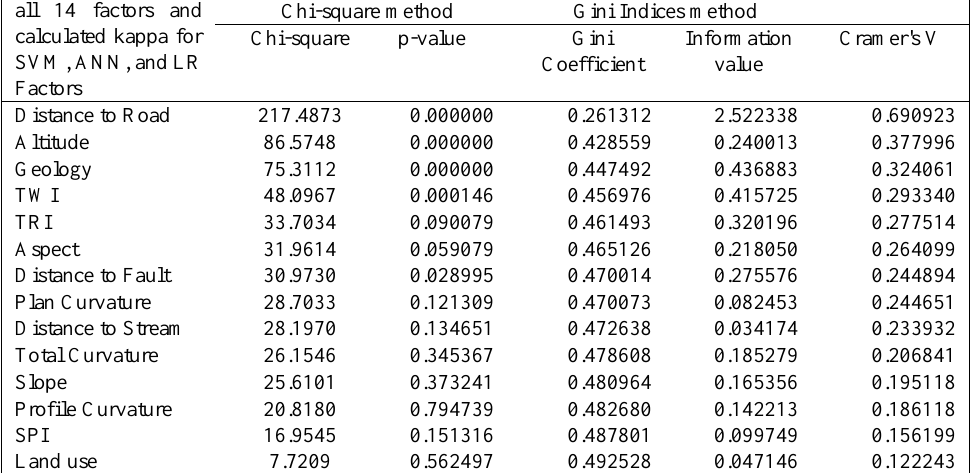
Table 4. The importance of factors using Gini importance and chi-square